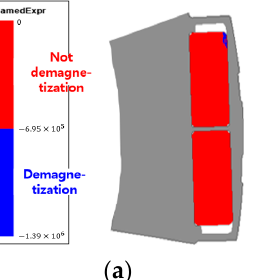
Figure 4. Irreversible demagnetization area obtained on inserting two magnets into a conventional model: ( a ) NdFeB magnet inserted, ( b ) Dy − free NdFeB magnet inserted.